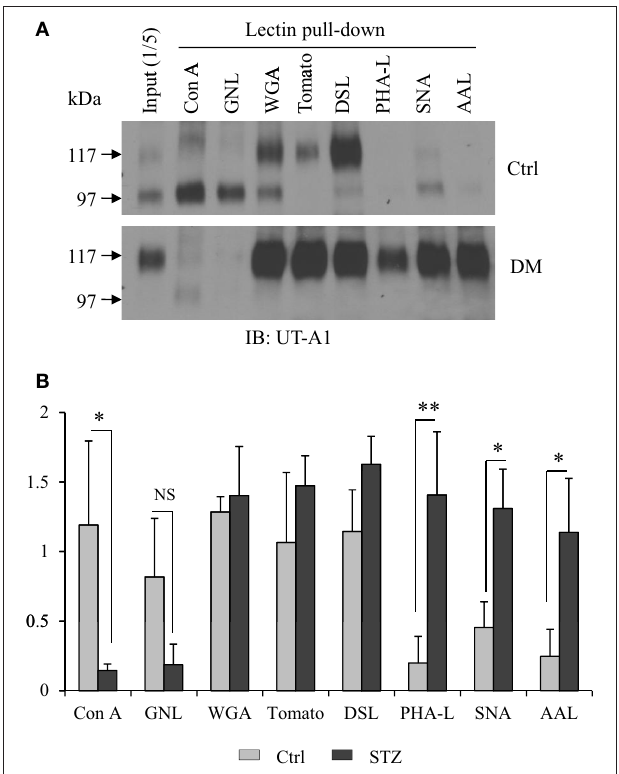
FIGURE 1 | Lectin pulldown assays. (A) Cell membrane lipid raft fractions isolated from control or STZ-diabetic rat IM tip were pooled and incubated with 30 µ l of indicated agarose-bound lectins at 4 ◦ C overnight. After washing, the lectin precipitated samples were analyzed by immunoblotting with anti-UT-A1 antibody. (B) Densitometry analysis of UT-A1 protein bands from three separate experiments ( n = 3 ). Each lectin precipitated UT-A1 was normalized with UT-A1 from input proteins (means ± SD, * P < 0.05 , ** P < 0.01 , NS, no significance).